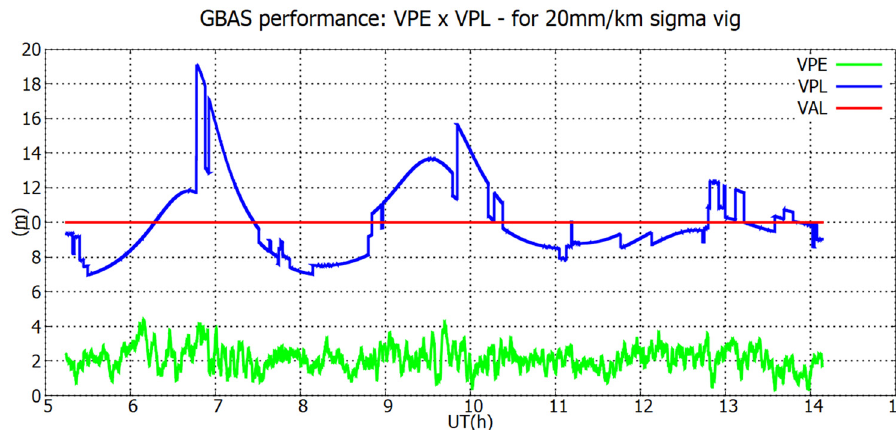
Figure 14: Performance of positioning errors and protection levels for GBAS simulation considering σ vig of 20